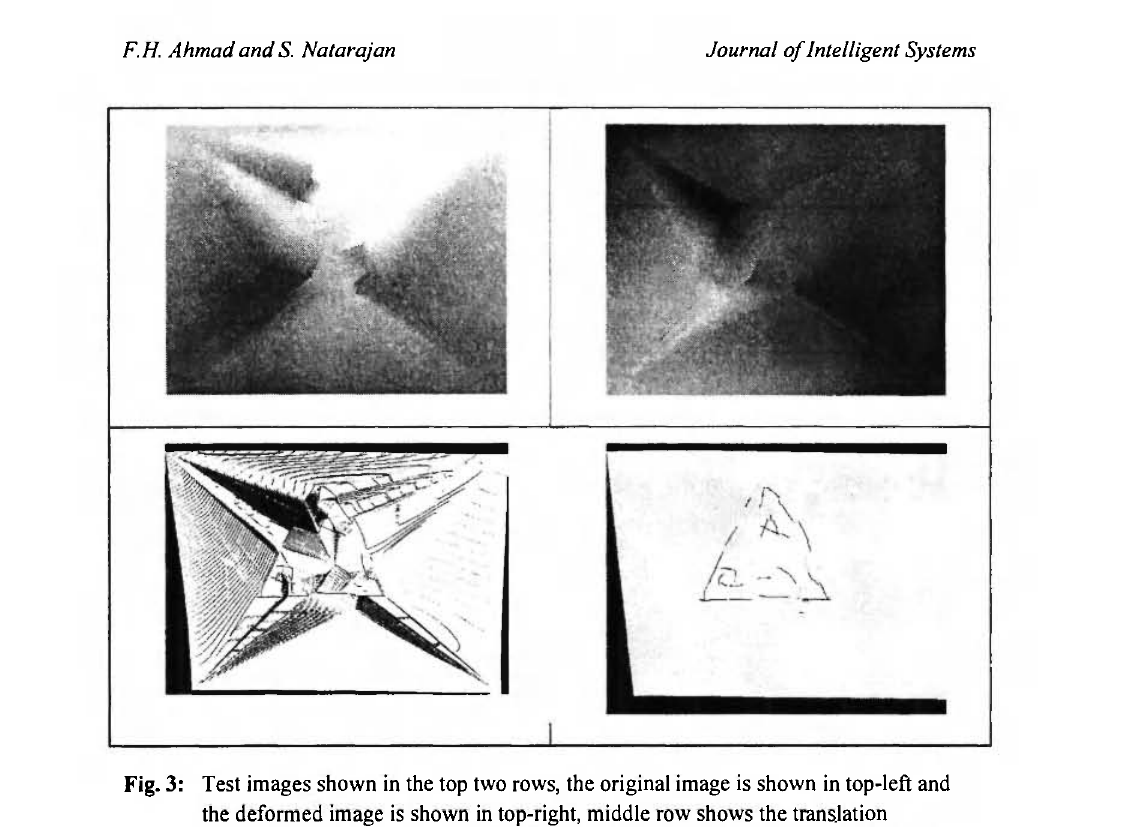
Fig. 3: Test images shown in the top two rows, the original image is shown in top-left and the deformed image is shown in top-right, middle row shows the translation parameters obtained for the rows (middle-right) and columns (middle-left) for the feature point